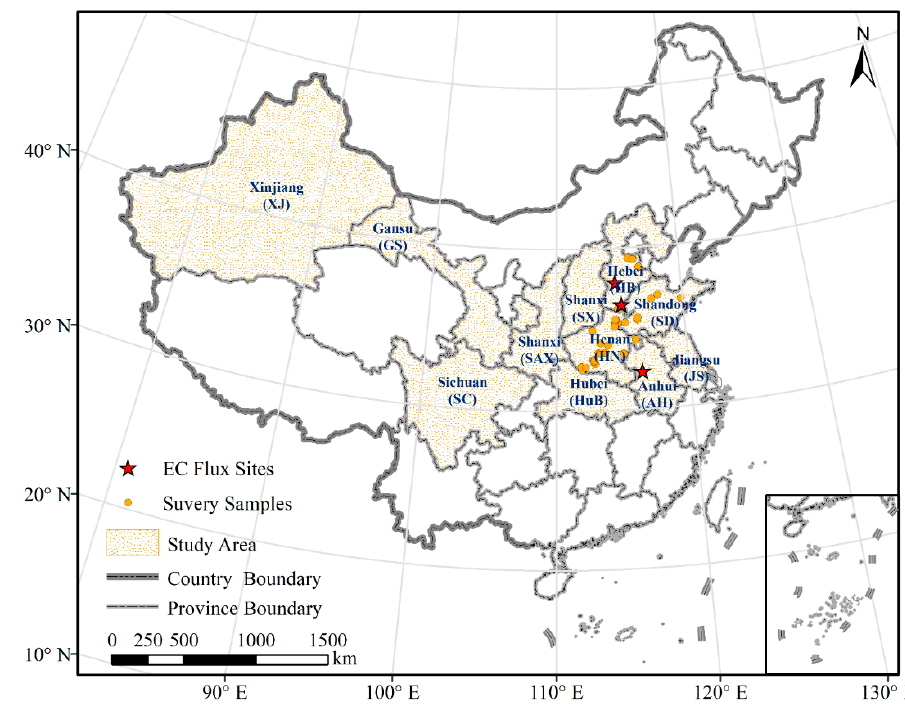
Figure 1. The location of the study area.